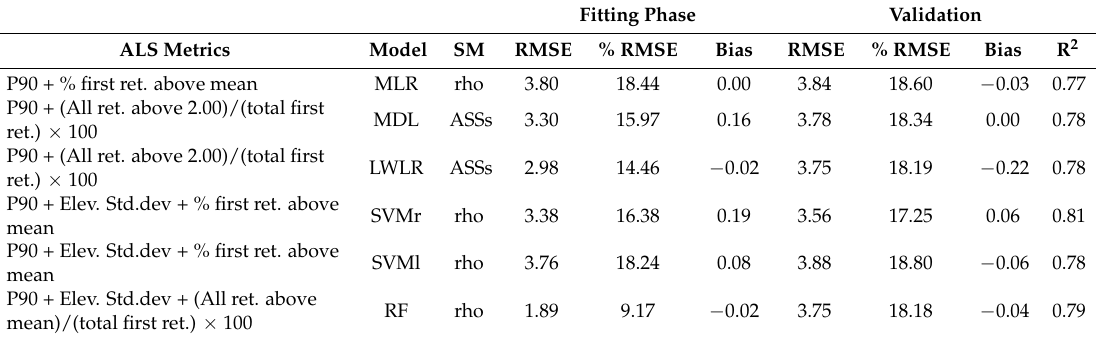
Table A6. Summary of the Dg models using 2011 ALS data. Validation results in terms of RMSE (cm), %RMSE, and bias (cm) and R 2 . SM refers to selection method; Step. stands for Stepwise both and forward; SVMr. refers to Support Vector Machine with radial kernel; SVM l. refers to Support Vector Machine with linear kernel; ret. refers to returns.